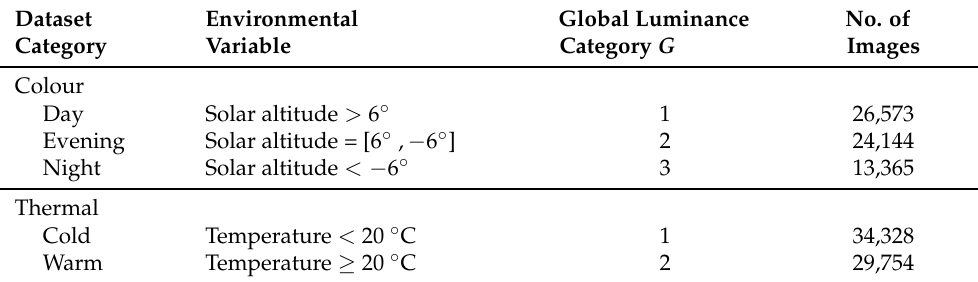
Table 2. Dataset